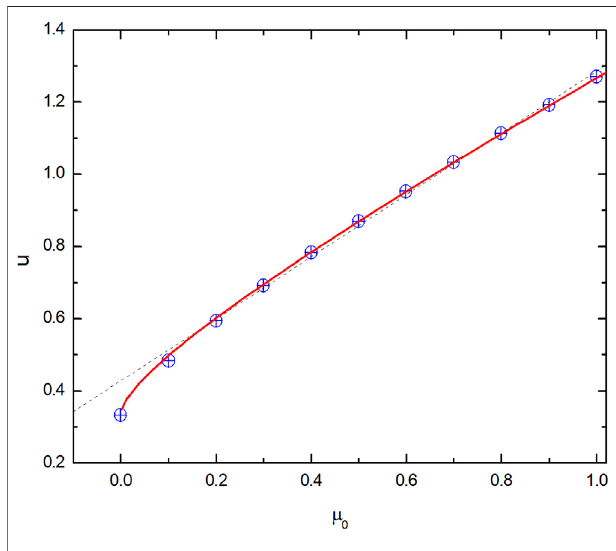
FIGUREA1.1 | Thedependence oftheescape function on thecosine of the solar zenith angle for the Henyey – Greenstein phase function at g (cid:1) 0.75 calculated using exact radiative transfer theory (symbols), and Eq. (A1.1) (solid line) and Eq. (A1.2) (dashed